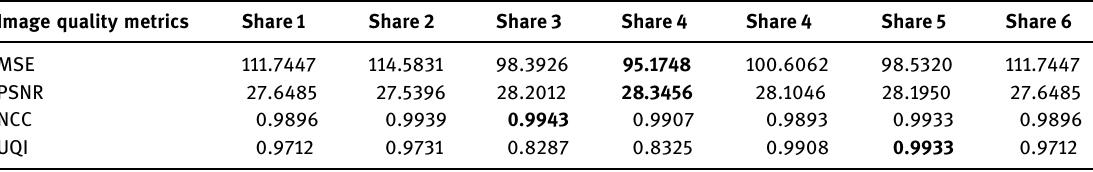
Image quality metrics